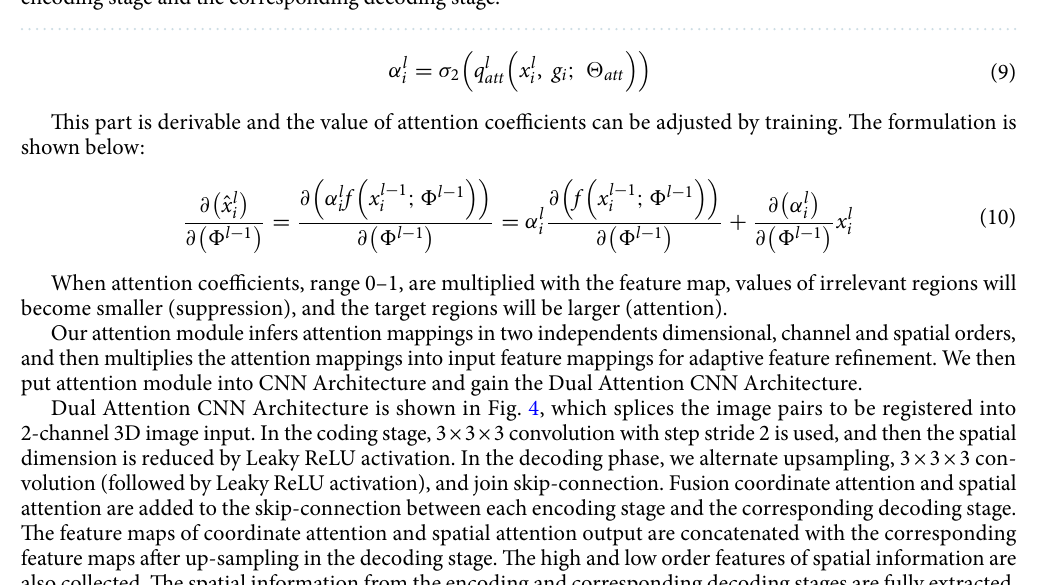
Figure 4. The dual attention CNN architecture. Each rectangle represented a 3D volume, generated from the previous volume by a 3D convolutional network layer. The spatial resolution of each volume was printed below. Fusion coordinate attention block and spatial attention block were added to the hop connection between each encoding stage and the corresponding decoding